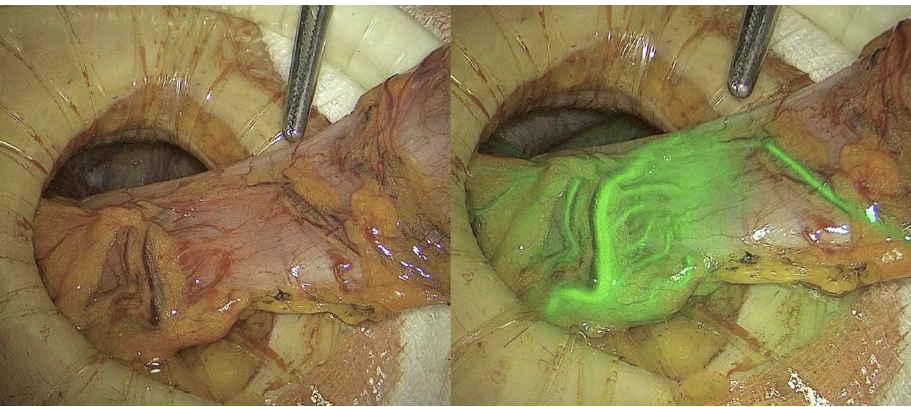
Figure 2. Bowel perfusion assessment using ICG. Courtesy of International Society for Fluorescence Guided Surgery (ISFGS).